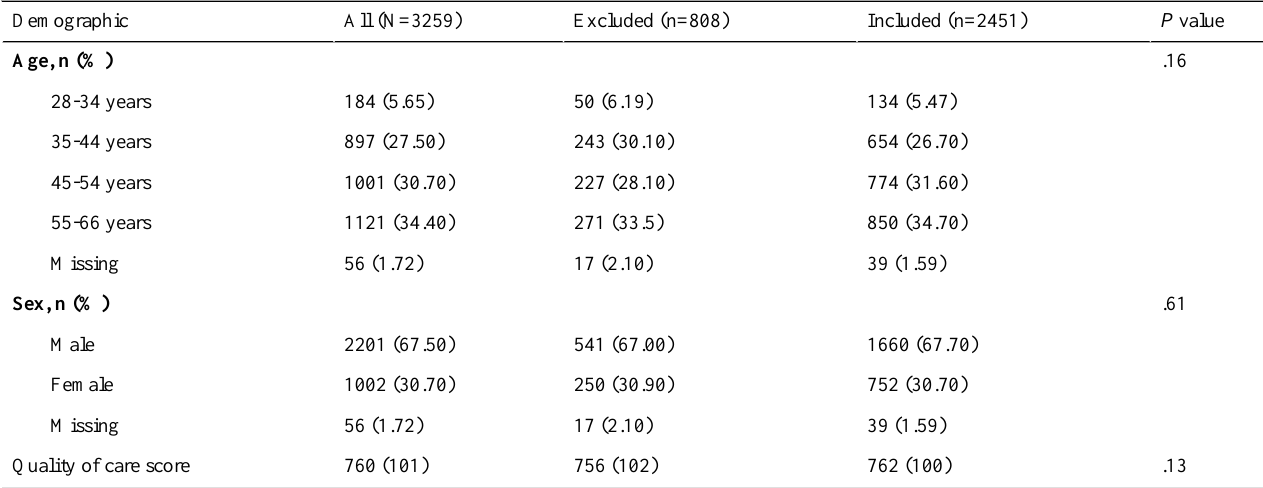
Table 1. Sociodemographic characteristics of doctors included and excluded in the